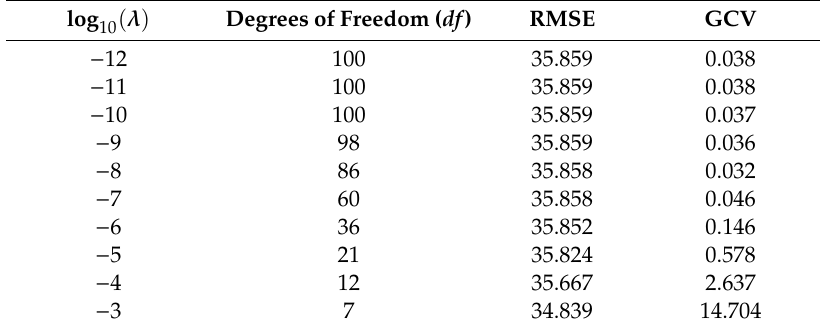
Table 1. Various values of λ with their respective df , RMSE, and